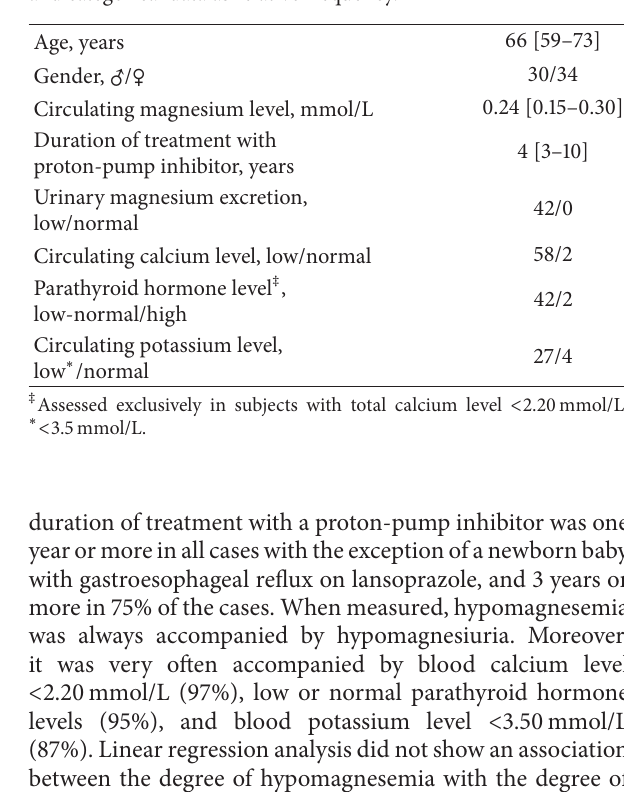
Table 1: Clinical and laboratory findings in 64 patients with hypo- magnesemia ( < 0.75 mmol/L) while being on long-term manage- ment with a proton-pump inhibitor. Numerical data are presented as median and interquartile range (which extends from the value at centile 25 to that at centile 75 and includes half of the data points) and categorical data as relative